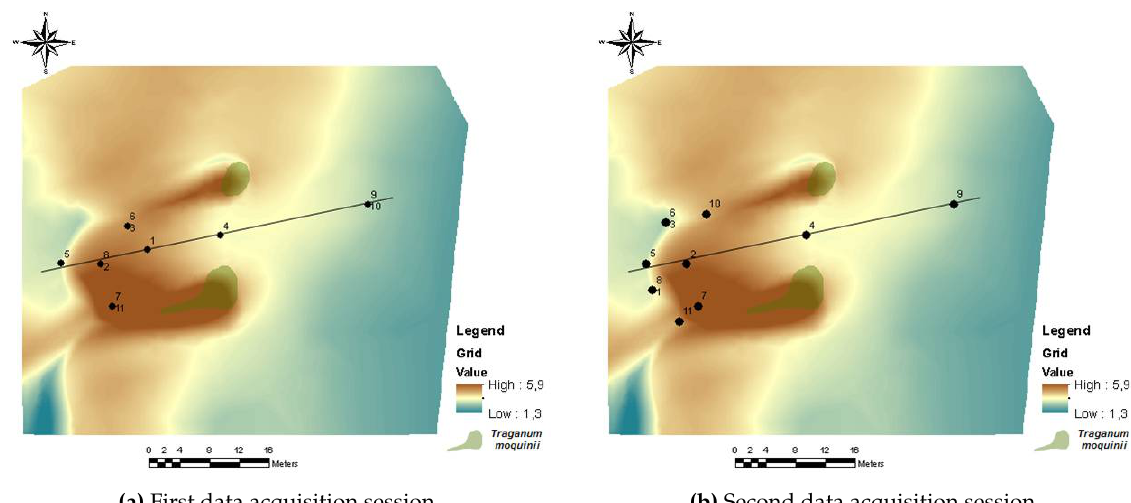
Figure 11. Wind sensor locations in both data acquisition sessions. The line shown in both figures is the longitudinal axis of the